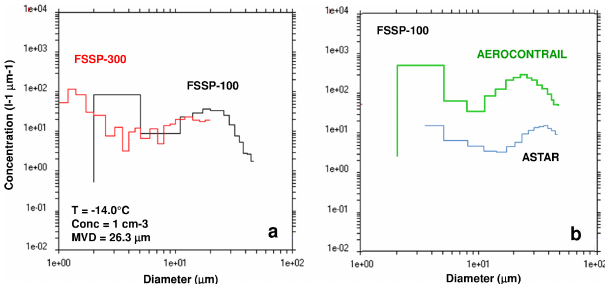
Fig. 6. (a) : Composite representation of the particle size distribu- tions measured simultaneously by the FSSP-100 and the FSSP- 300 in mixed phase clouds during the POLARCAT experiment (12 July 2008). (b) : Composite representation of the particle size distributions measured by the FSSP-100 during ASTAR with an air- speed of 100ms − 1 and during AEROCONTRAIL with an airspeed of 200ms − 1